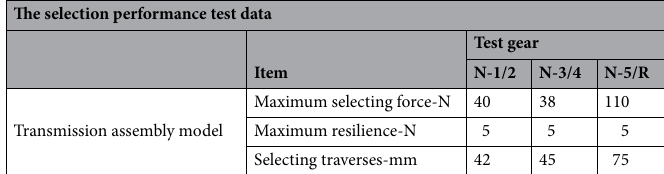
Figure 5. The actual selection performance curve.